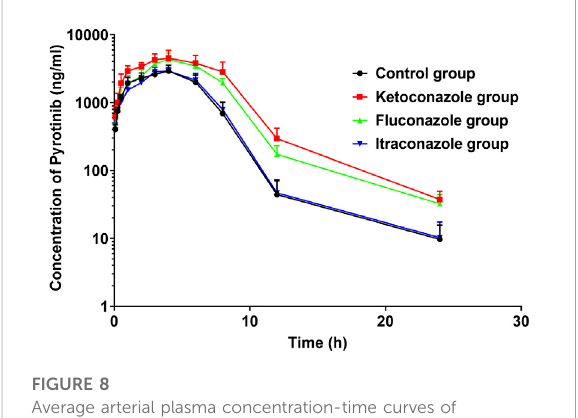
FIGURE 8 Average arterial plasma concentration-time curves of pyrotinib in rats in the Control group, ketoconazole group, fl uconazole group and itraconazole group ( n =